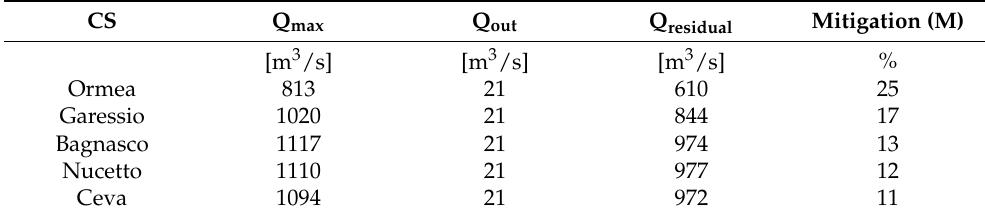
Table 7. The mitigation effect of the single Negrone River dam as for its OS; the outgoing flow rate is equal to 21 m 3 /s.